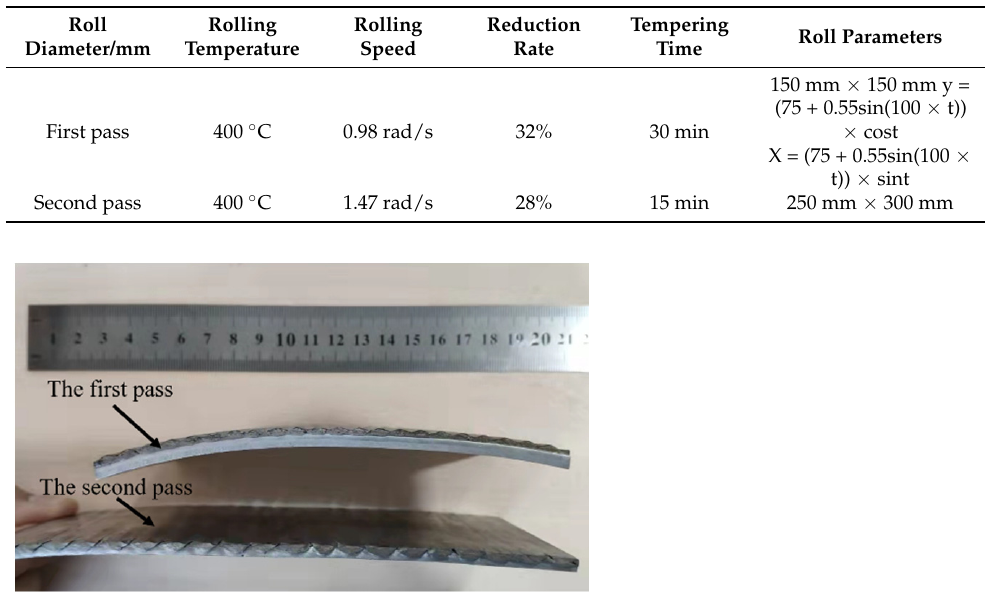
Figure 2. Schematic diagram of Mg/Al corrugated composite plate after rolling in different passes.